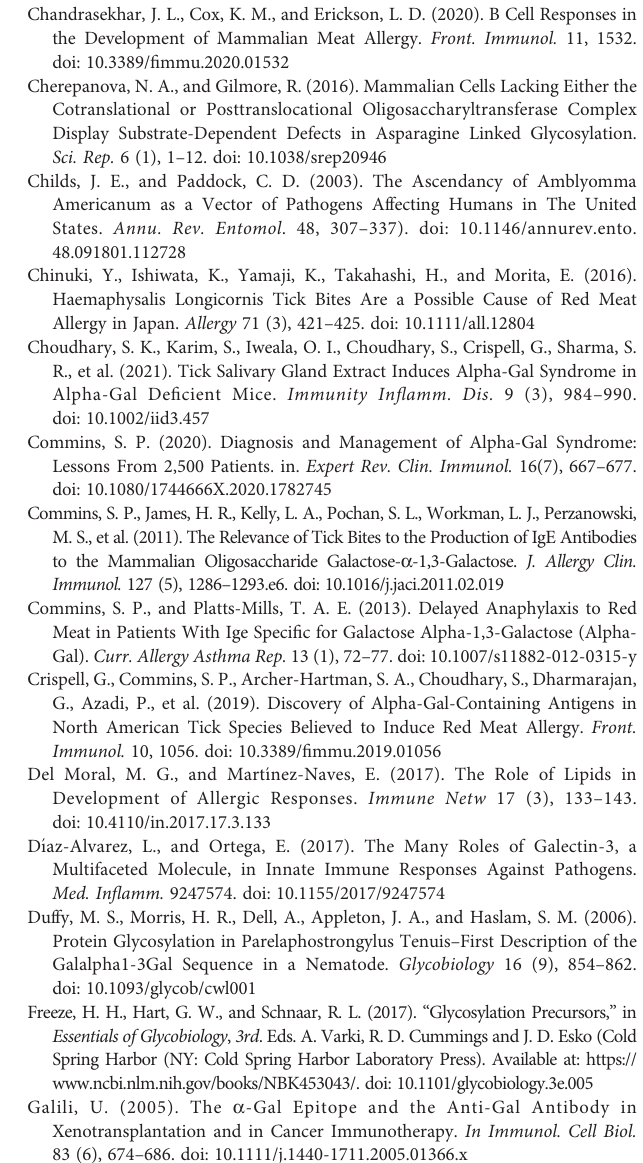
Supplementary Table 1 | Summary of potential a -Gal Glycoforms Determined by MS/MS Analysis. Supplementary Table 2 | FTMS of N-Glycans observed in control salivary glands. Supplementary Table 4 | Frequency of basophil activation. Miscellaneous Supplementary Figures FTMS of all N-glycans observed in KO salivary and control